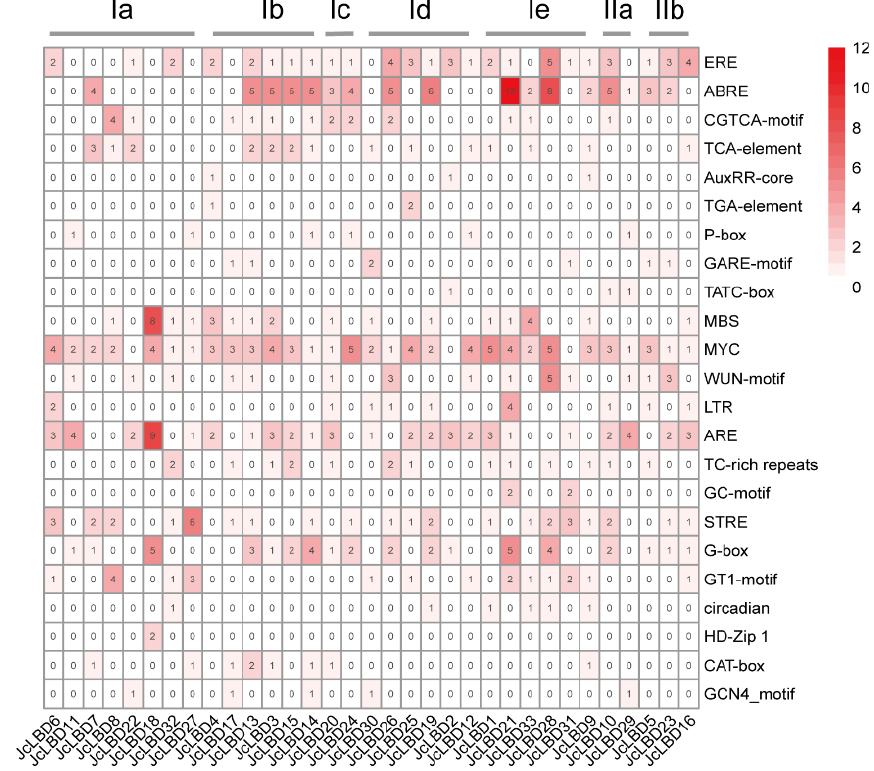
Figure 3. Cis -acting element matrix identified in the 1500-bp upstream promoters of each JcLBD s.